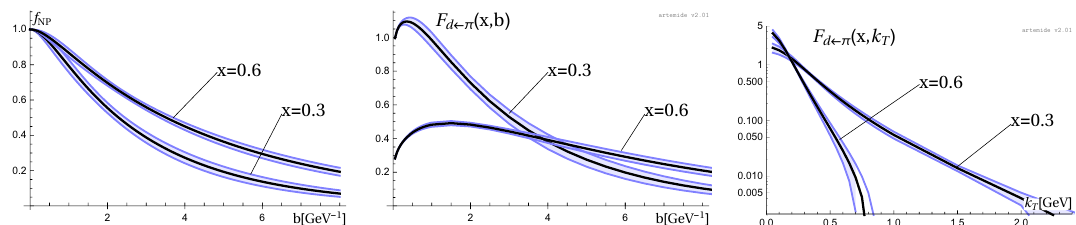
Figure 1 . (Left) The function f NP that parametrizes the non-perturbative part of TMDPDF for pion 2.6. (Center) Pion TMDPDF for d -quark in b -space. (Right) Pion TMDPDF for d -quark in k T -space. The bands are the 1 (cid:27) uncertainty band related to the data error-bands and calculated by the replica